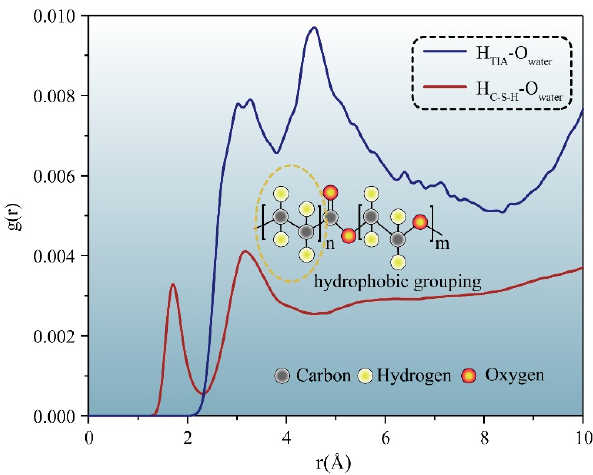
Figure 8. Radial distribution function of oxygen atoms in solution and hydrogen atoms in the sys ‐ tem.